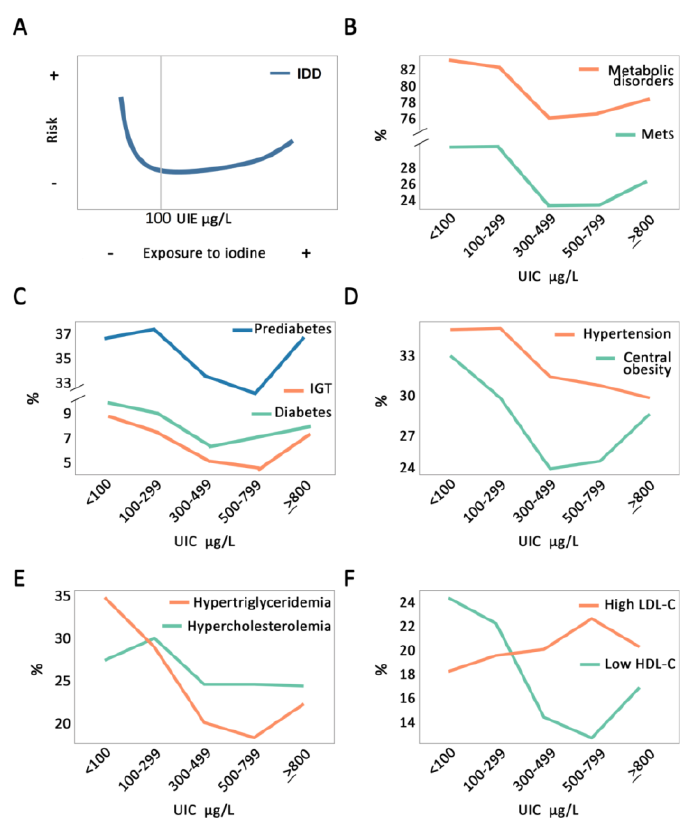
Figure 3. Association of diseases and iodine intake. ( A ) Exposure to iodine and the risk of developing IDD ([67] data from [79], Academic Press, 2009). Relationship between UIC (µg/L) and the prevalence (%) of ( B ) metabolic disorders and MetS, ( C ) prediabetes, diabetes, and IGT, ( D ) hypertension and central obesity, ( E ) hypertriglyceridemia and hypercholesterolemia, and ( F ) HDL-C and LDL-C (data from [70], Mary Ann Liebert, Inc., publishers). Abbreviations: HDL-C, high-density lipoprotein cholesterol; IGT, impaired glucose tolerance; IDD, iodine deficiency disorders; LDL-C, low-density lipoprotein cholesterol; MetS, metabolic syndrome; UIE, urinary iodine excretion; UIC, urinary iodine concentration.